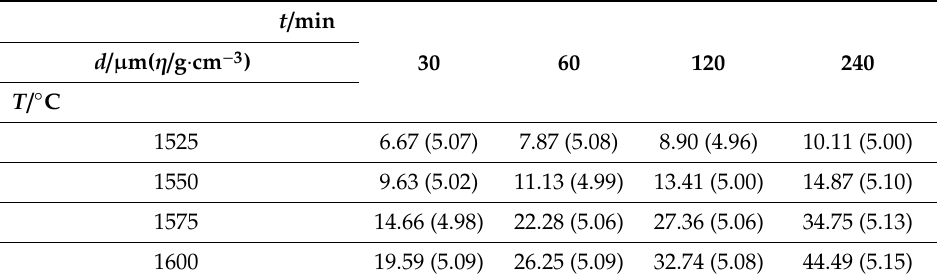
Table 1. Average grain size ( d ) and density ( η ) of 0.65CLT-0.35SMT ceramics sintered at di ff erent sintering temperatures ( T ) for di ff erent holding times ( t ).